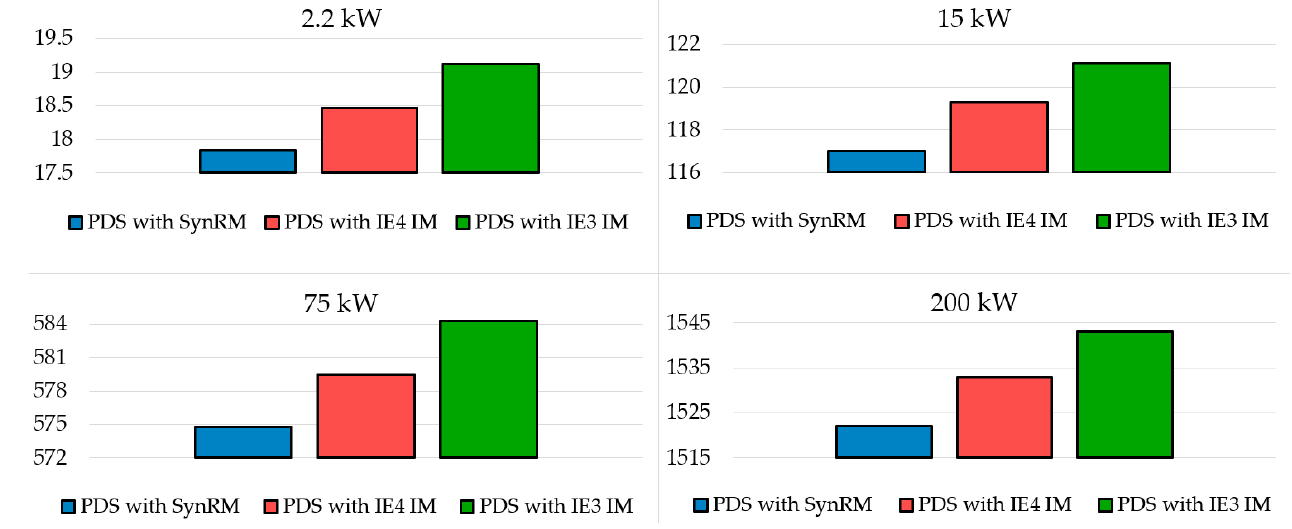
Figure 5. Annual energy consumption (MW·h). Table 6. Results for the PDS electricity costs and cost savings.